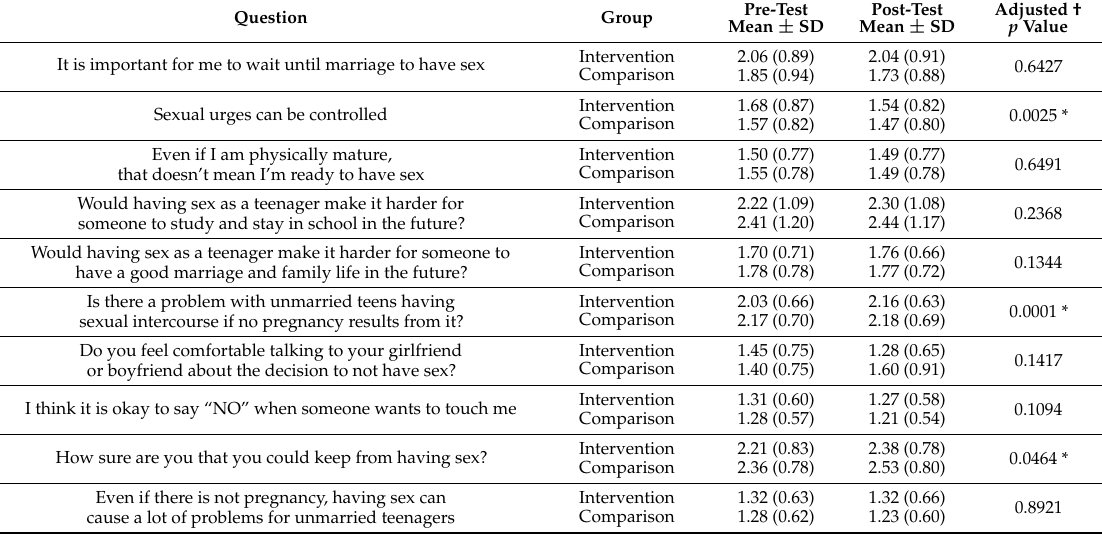
Table 5. Generalized linear model for attitudes and beliefs about sex and